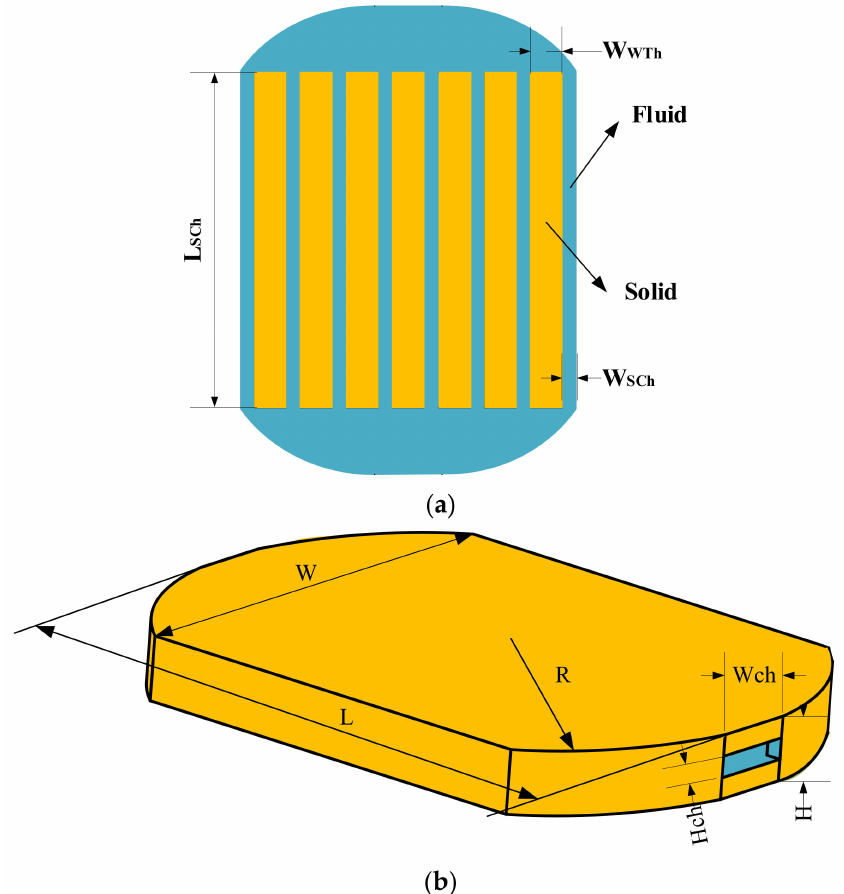
Figure 5. Sketch of traditional straight mini-channel heat sink. ( a ) 2D structure of straight mini- channel; ( b ) Structure of heat